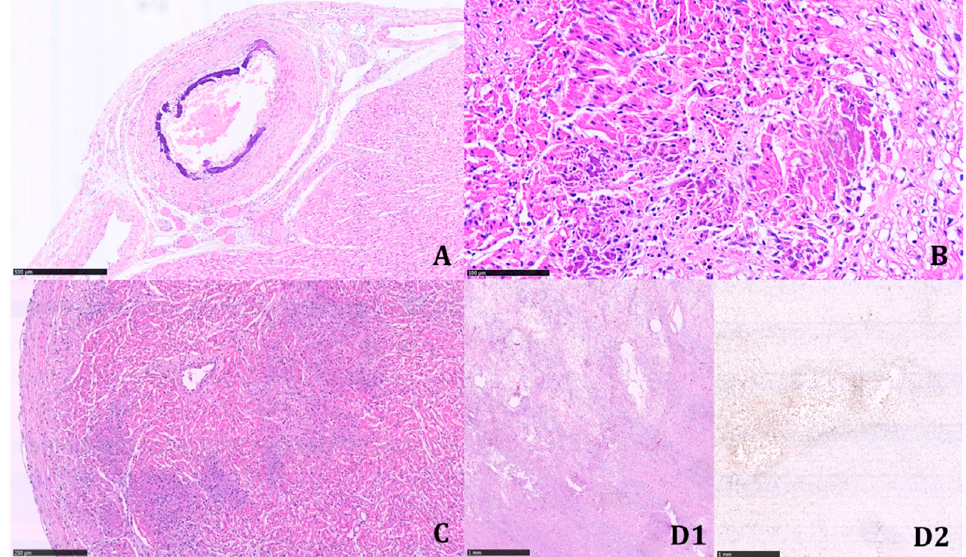
Figure 5. Ischemic visceral changes during GACI. ( A ) Extensively calcific coronary vessel (H&E; 6.29×). ( B ) Cardiac left ventricle: intramyocardial fibrocalcific area; arrows indicate some extravas- cular calcifications (H&E; 28.5×). ( C ) Left cardiac ventricle; the purple areas indicate myocardial ischemic degeneration (H&E; 10.3×). ( D1 ) Brain white matter: infarction in intermediate stage of development (upper left area) (H&E; 2,18×). ( D2 ) Same area of the previous image; the immuno- histochemical staining for CD68 identifies the marked macrophagic infiltration in the area with is- chemic necrosis (CD68-KP1; 2.18×). All histological preparations were digitized and photographed with Nanozoomer 360, Hamamatsu. (Scale bars: A: 500 µm; B: 100 µm; C: 250 µm; D1: 1 mm; D2: 1 mm).